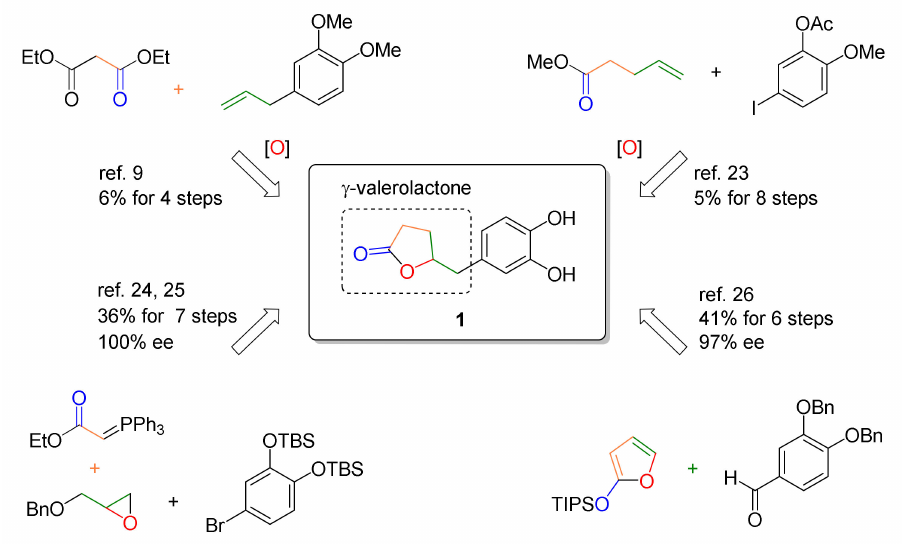
Figure 2. Previous synthetic approaches toward